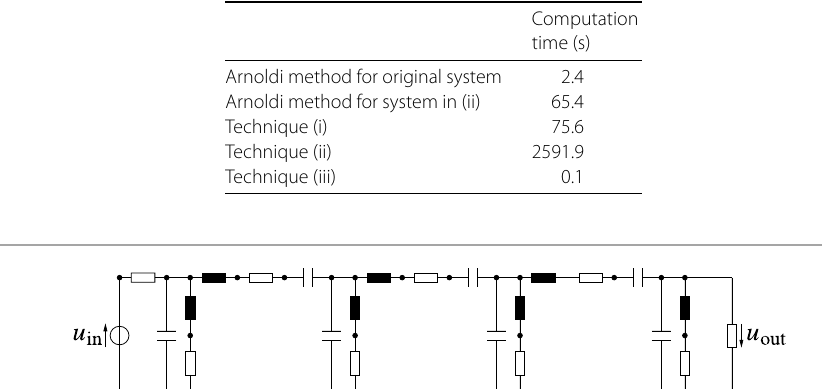
Table 4 Computation times for MOR method producing reduced dimension r = 100 and additional stabilization techniques in mass-spring-damper example